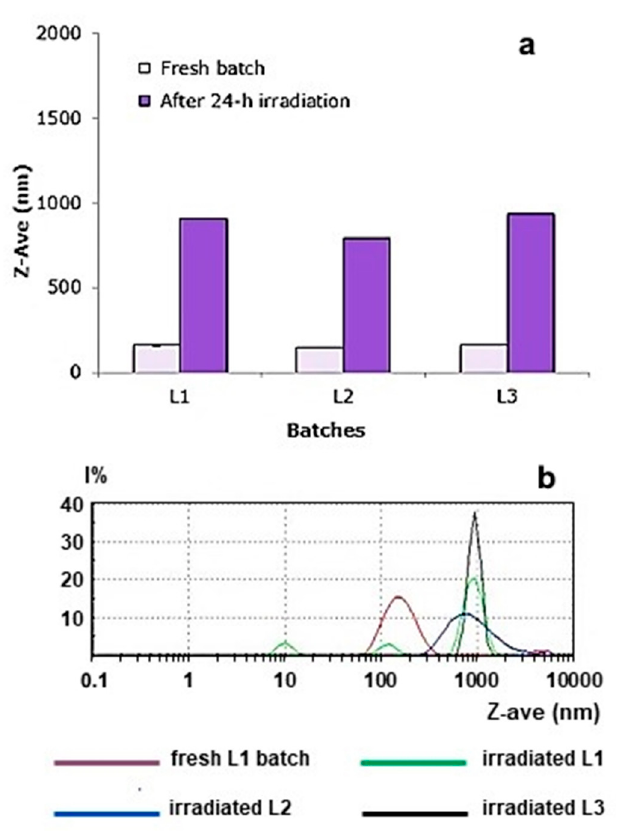
Figure 7. ( a ) Changes of Z-Ave values of blank nanoparticles after 24-h exposure to an incandescent lamp; ( b ) experimental results of the photon correlation spectroscopy (PCS) analysis for batches L1, L2, and L3 after exposure to light, compared to the fresh L1 batch.